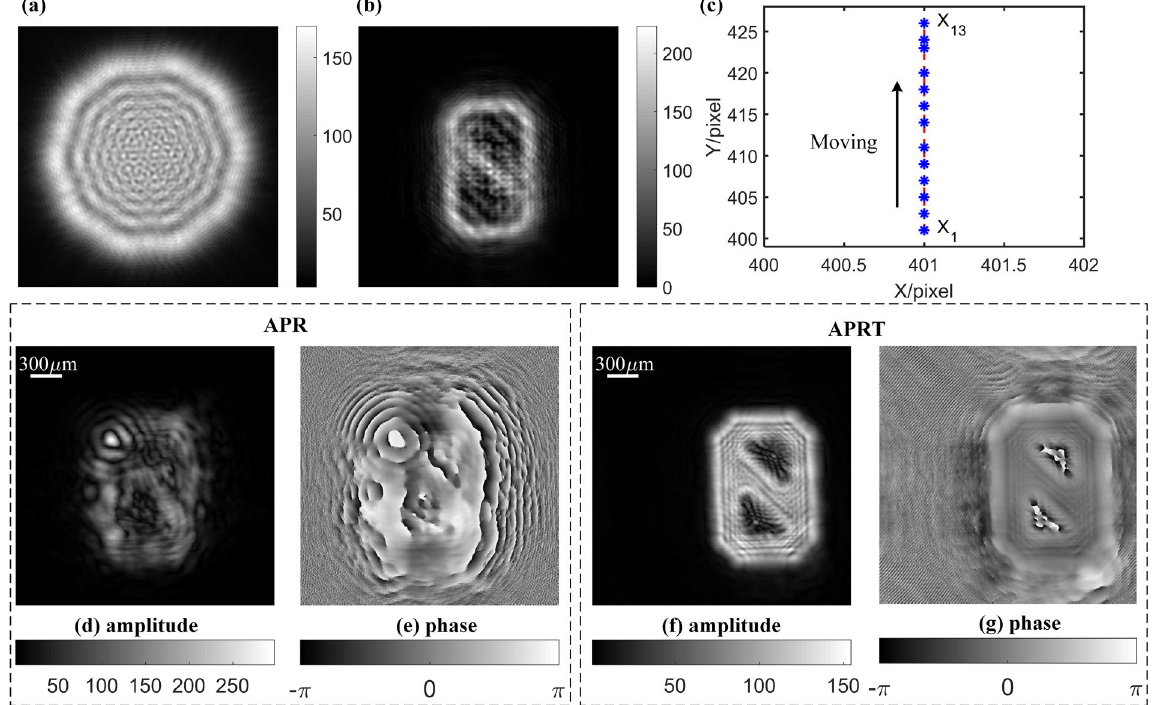
Figure 6. Recorded data and reconstructed complex amplitude in Z 0 = 60 mm, d = 1 mm, N = 13, M = 800: ( a ) Diffraction disc of incident light in Z 1 = 60 mm. ( b ) Diffraction pattern in Z 1 = 60 mm. ( c ) The movement of the peak position of cross-correlation; ( d ) and ( e ) are reconstructed amplitude and phase by APR algorithm, respectively; ( f ) and ( g ) are reconstructed amplitude and phase by APRT algorithm, respectively. Here iterative number is fixed at 2000.